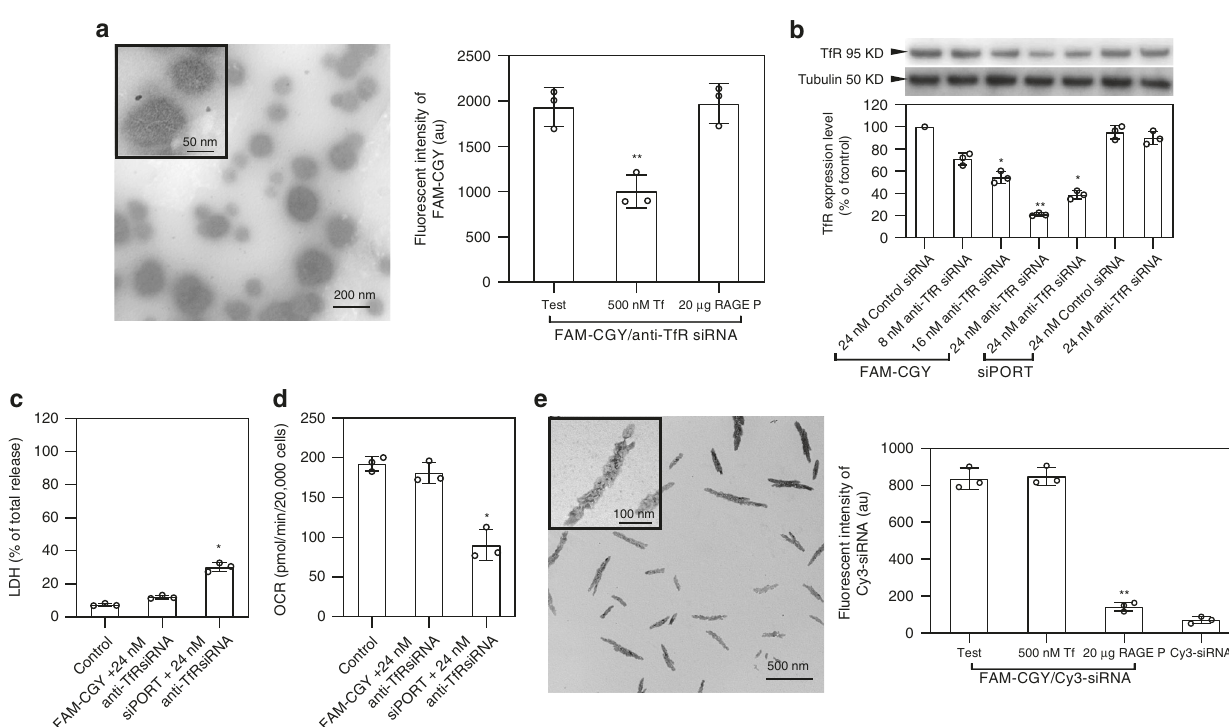
Fig. 3 NLC-siRNA complexes and their cellular performance. a Transmission electron micrograph of FAM-CGY/TfR-speci fi c siRNA complexes (left panel) and their uptake by hCMEC/D3 cells. The uptake is signi fi cantly reduced in the presence of human Tf, but not the RAGE P ligand. b FAM-CGY/TfR-speci fi c siRNA complexes effectively silence TfR in hCMEC/D3 cells as determined by Western blotting. Silencing is also compared with TfR-speci fi c siRNA alone and when delivered with the commercial transfectant siPORT. c Transfection with siPORT, but not with FAM-CGY, causes cell damage as measured through cytoplasmic lactate dehydrogenase (LDH) release. d Transfection with FAM-CGY has no signi fi cant effect on cell oxygen consumption rate. ATP turnover and respiratory control ratio are unaffected by FAM-CGY (see Supplementary Table 1 for full data analysis). e The left panel shows transmission electron micrographs of complexes between FAM-CGY and Cy3-siRNA forming twisted single or multiple fi bres. The right panel shows the uptake